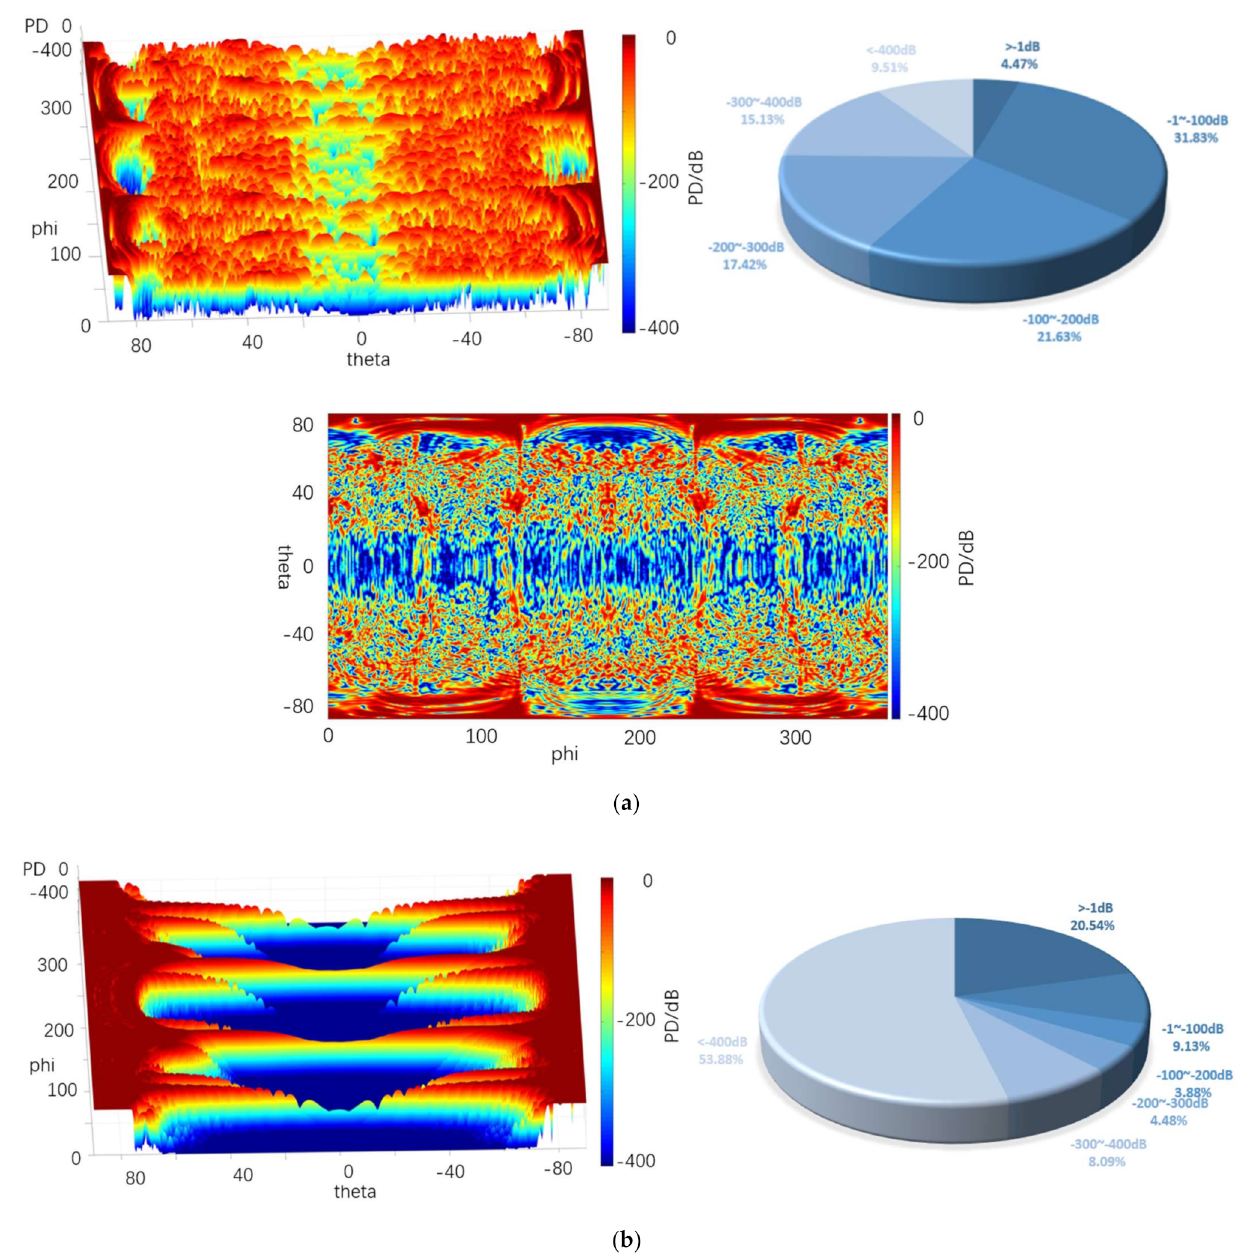
Figure 24. Probability distribution in the 4 π direction of 2.7 m 2 . ( a ) Quantum detection probability, ( b ) Probability of conventional